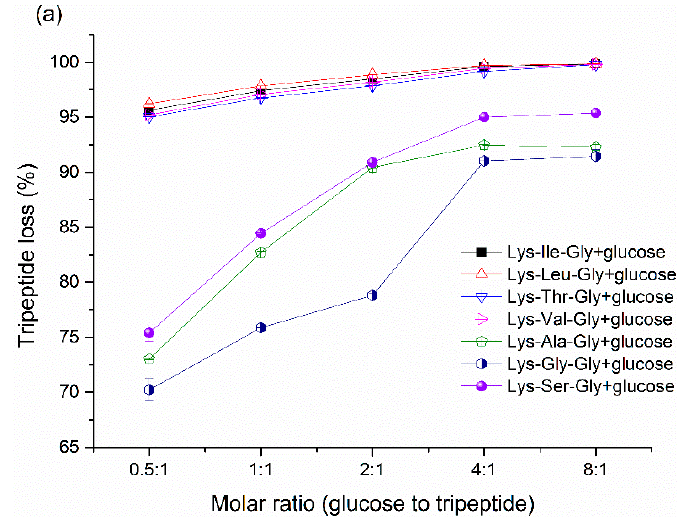
Figure 4. Cont . Figure 4.